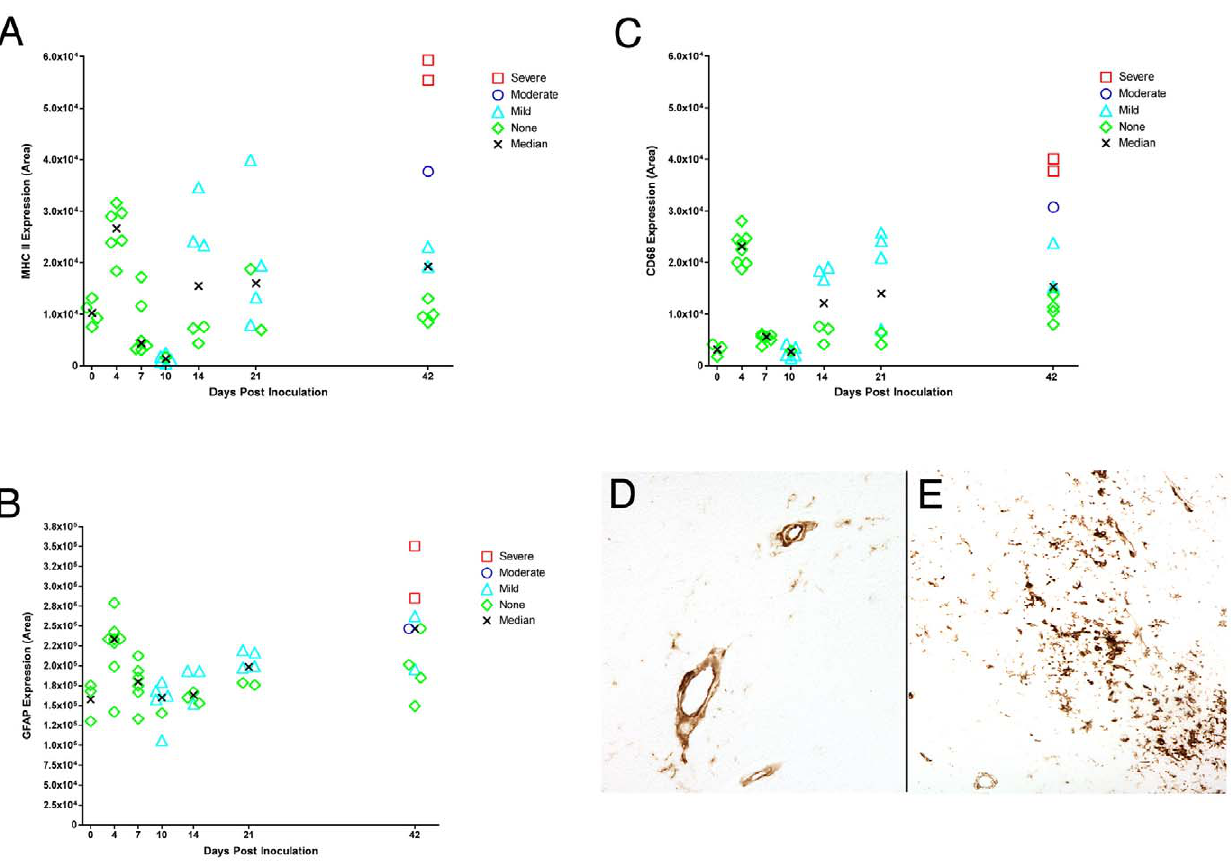
Figure 6. Expression of MHC Class II, CD68 and GFAP in brain of SIV-infected macaques. Quantitative immunohistochemistry was used to measure A) MHC class II; B) CD68; and C) GFAP in brain from SIV-infected macaques at terminal time points (4, 7, 10, 14, 21, or 42 days p.i.). The quantification of each protein is based on the mean of 20 measures on brain from each macaque. D) MHC class II expression in brain at 4 days p.i. E) CD68 expression in brain at 4 days